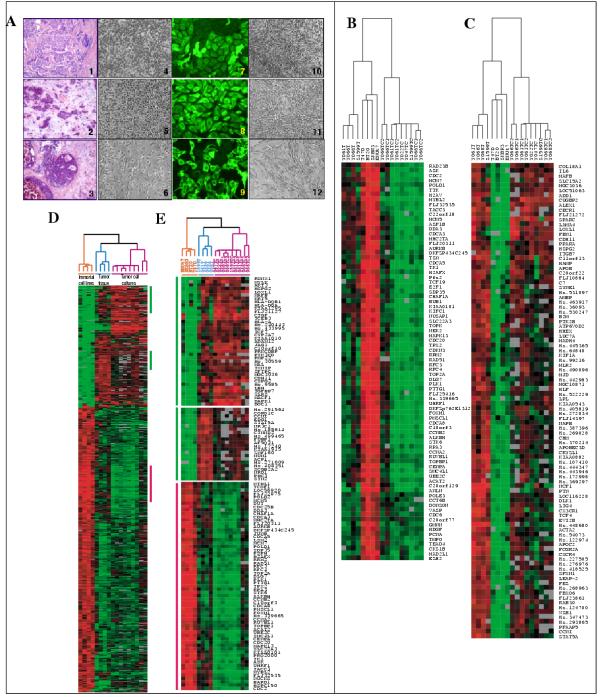
A. Microscopic phenotype of primary tumor tissue and corresponding tumor-derived epithelial and stromal cell cultures. (1–3) – H & E-stained frozen sections showing histology of representative cases processed for RNA isolation and cell culture. Case number 061T – 1; 066T – 2; 068T – 3. Note abundant tumor cells in the samples. (4–6) – Early passage epithelial cultures; brightfield, 100× magnification. Note morphological variation between cultures in the context of an epithelial phenotype. (7–9) – abundant cytokeratin expression in the cytoplasm of cultured primary tumor cells analyzed by indirect immunofluorescence. Magnification – 400×. (10–12) – tumor-derived fibroblast cultures; brightfield, 100× magnification. Note morphological distinction between epithelial and stromal cells isolated from the same tissue sample. B – E. cDNA-based gene expression profiles of tumor tissue and tumor derived epithelial cultures. Rows represent genes, and columns represent samples. B, C – unsupervised two-dimensional hierarchical clustering of 17 samples. B – cluster shows genes under expressed in primary tumor tissue and tumor cultures compared to immortal cell lines. C – cluster shows genes over expressed in primary tumor cultures and tumor tissue compared to immortal cell lines. D, E – Gene expression patterns, which distinguish between group 1, consisting of immortal cell lines, and group 2, consisting of primary tumor tissue and tumor cultures. D – Results of SAM analysis showing a thumbnail of 681 differentially expressed genes. E – SAM-identified genes which are in common with the cluster in panel B are shown by red vertical bar, and with the cluster in panel C are shown by green vertical bars. Color scale indicates expression level.